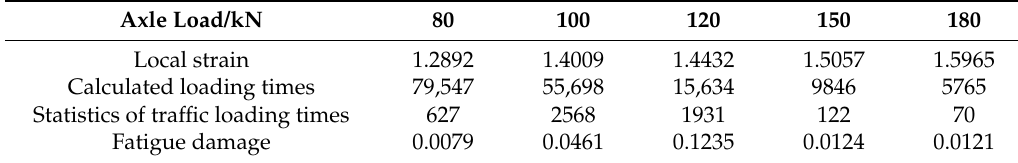
Table 14. The analysis of fatigue